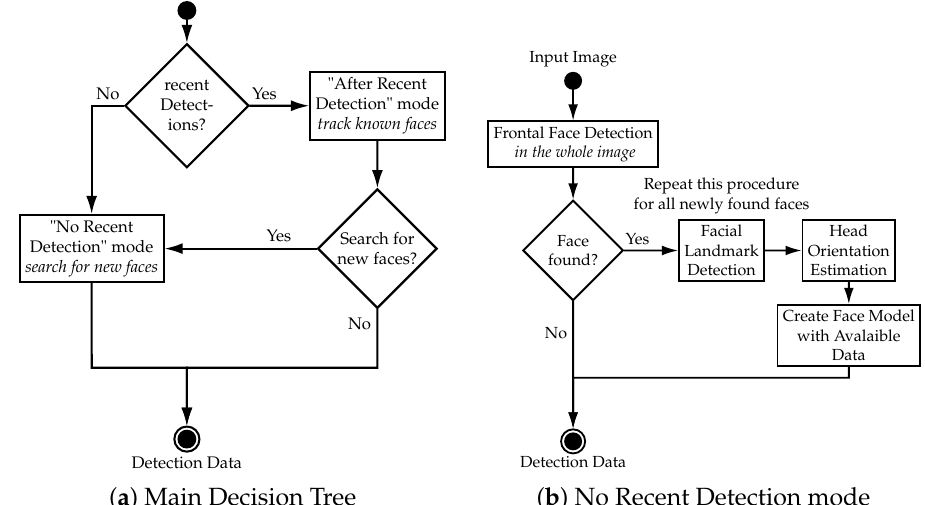
Figure 4. Decision tree of the main face tracking algorithm and “No Recent Detection” mode. The rectangle shapes illustrate tasks of the algorithm and the diamond shapes symbolize decisions.